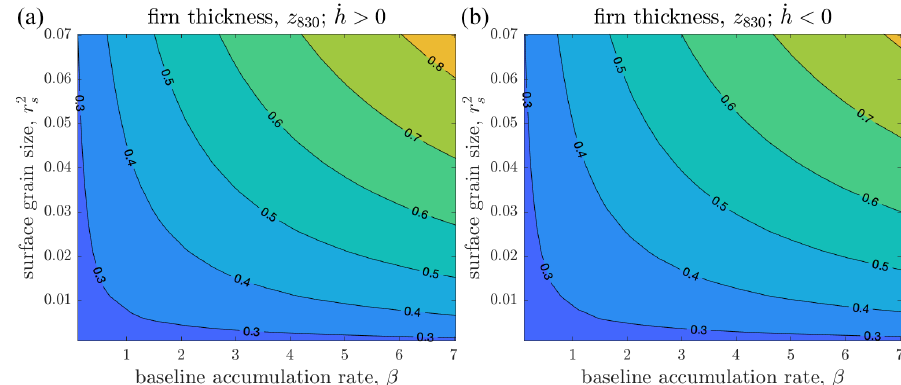
Figure 8. Steady-state firn thickness z 830 simulated with the full model during steadily (a) increasing and (b) decreasing ice surface height and domain length h , as functions of surface grain-size r 2 s and the baseline accumulation rate β . Simulations use the same parameters as used to produce Fig. 4 except that the baseline accumulation rate in Eq. (19) is multiplied by (a) 1.1 and (b) 0.9 to force continuous surface height change. Colour scales are the same as used in Figs. 6 and 7. Simulations terminate after a nondimensional time of 1 /β , which provides enough simulation time for the variation in φ with respect to the surface to reach a steady